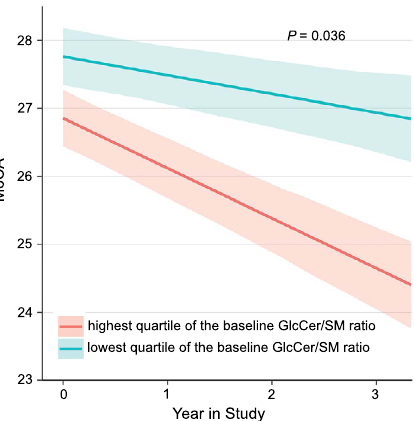
Fig. 3 Strati fi cation of idiopathic PD based on the ratio of glucosylceramide to sphingomyelin (GlcCer/SM ratio) at enroll- ment. Idiopathic PD patients with the highest quartile of GlcCer/SM ratio at enrollment (magenta) had an accelerated longitudinal cognitive decline compared to those with the lowest quartile of GlcCer/SM ratio (cyan). Model-predicted mean Montreal Cognitive Assessment (MoCA) scores (solid lines) and standard errors (shaded areas) across time are shown for idiopathic PD patients in the highest ( n = 48) and lowest ( n = 47) quartile of GlcCer/SM ratios at enrollment visits. Fixed effects covariates included in the model were time in study (years), GlcCer/SM ratio, the interaction of GlcCer/ SM ratio and time in study, age at baseline, the interaction of age at baseline and time in study, and sex. For the purpose of the graph, sex was arbitrarily set to female. Similar results were seen when sex was set to male (not